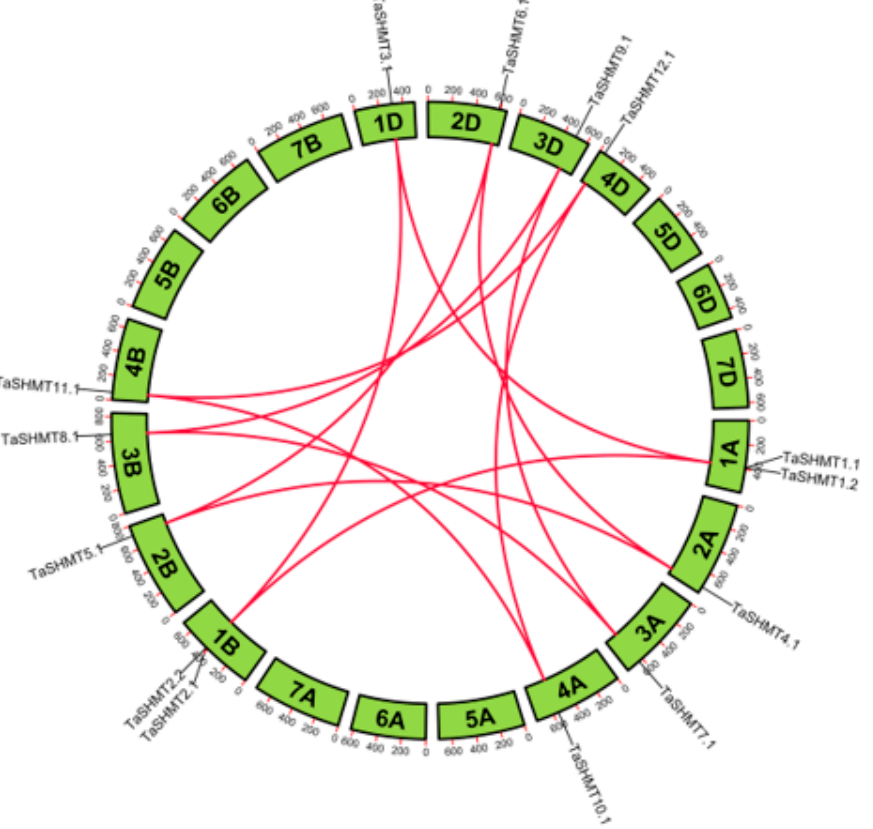
Figure 2. Chromosomal localizations and syntenic relationships among TaSHMT genes in wheat. Figure 3. Syntenic relationships between TaSHMT genes in T. aestivum with other SHMT genes in Red lines indicate the syntenic TaSHMT gene five other representative plant species. Gray lines in the background indicate the collinear blocks within T. aestivum and other plant genomes. Red lines indicate the syntenic SHMT gene pairs.